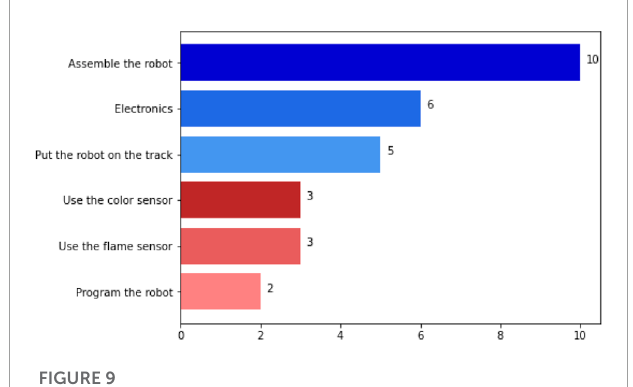
FIGURE 9 Number of answers to the question about the easiest activities for students in the Vulcano challenge.